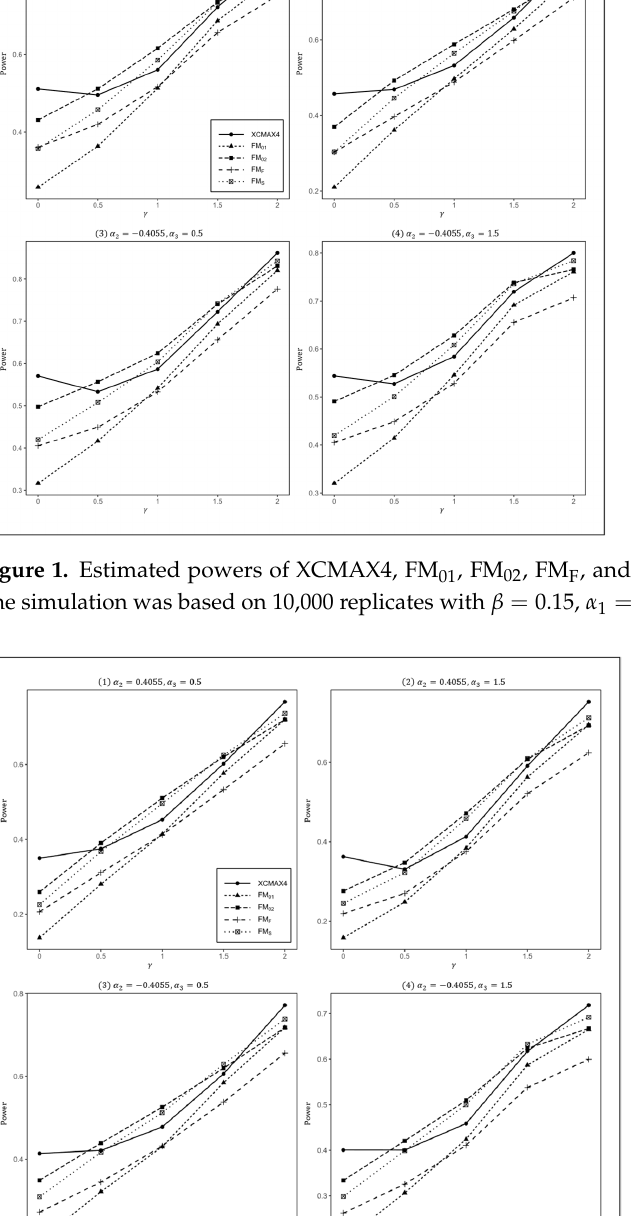
Figure 3. Estimated powers of XCMAX4 , FM (cid:2868)(cid:2869) , FM (cid:2868)(cid:2870) , FM (cid:2890) , and FM (cid:2903) under various XCI models. The simulation was based on 10,000 replicates with 𝛽 = 0.15 , 𝛼 (cid:2869) = −5 , 𝐹 = 0 , 𝑞 (cid:3033) = 0.2 , and 𝑞 (cid:3040) = 0.3 .